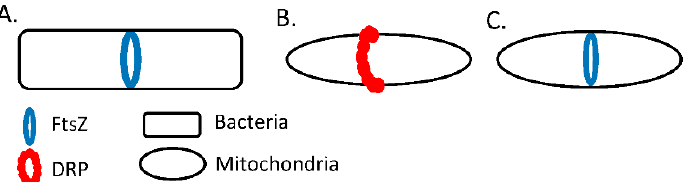
Figure 4. Schematic of ( A ) prokaryotic cell division, ( B ) mitochondrial fission in yeast or mammals, and ( C ) hypothesized mechanism of mitochondrial fission in D. discoideum . FtsZ is the primary component found in the cytokinetic ring of prokaryotic cells. DRP represents the dynamin-related proteins that mediate mitochondrial division in yeast and mammals but not D. discoideum.